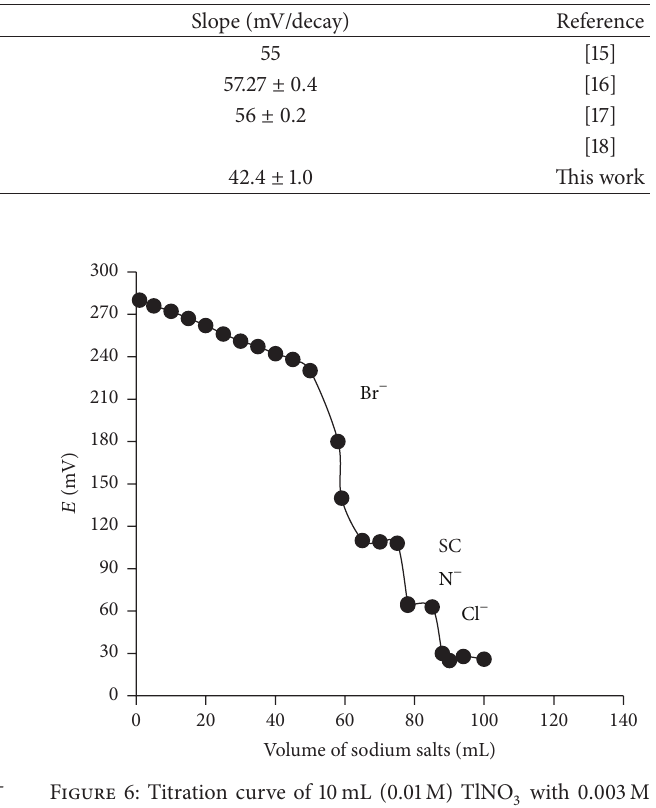
Figure 6: Titration curve of 10mL (0.01M) TlNO 3 with 0.003 M NaBr, 0.1M NaSCN, and 0.1M NaCl solutions.